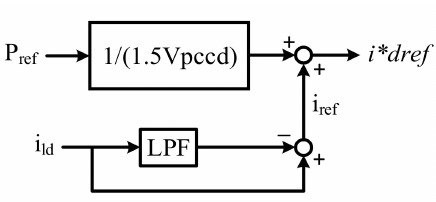
Figure 12. Reference current generator block diagram in [29].